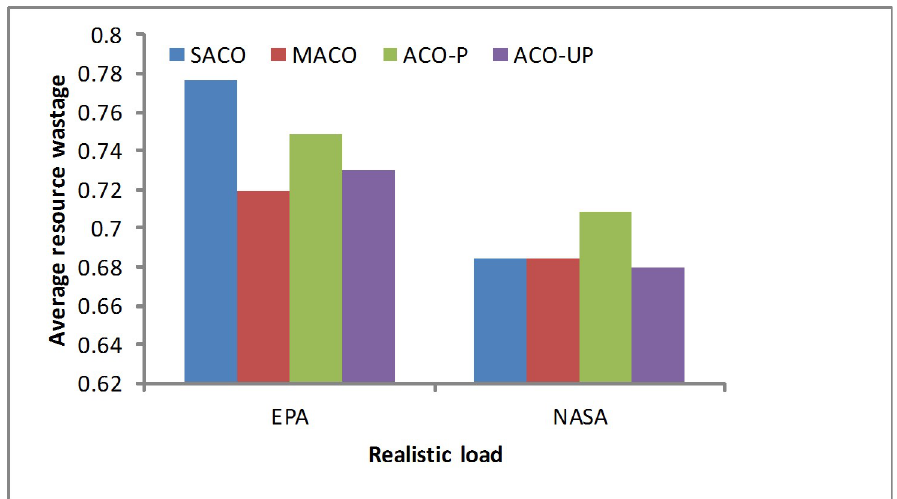
Fig 12. CPU resource wastage rates under the realistic